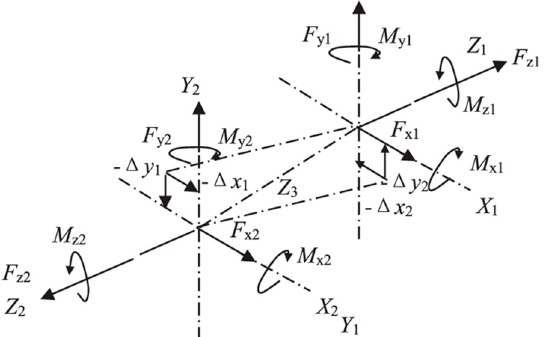
Figure A1. Schematic of the Gibbons parallel misalignment model. Reprinted with permission from ref. [82]. Copyright 2021